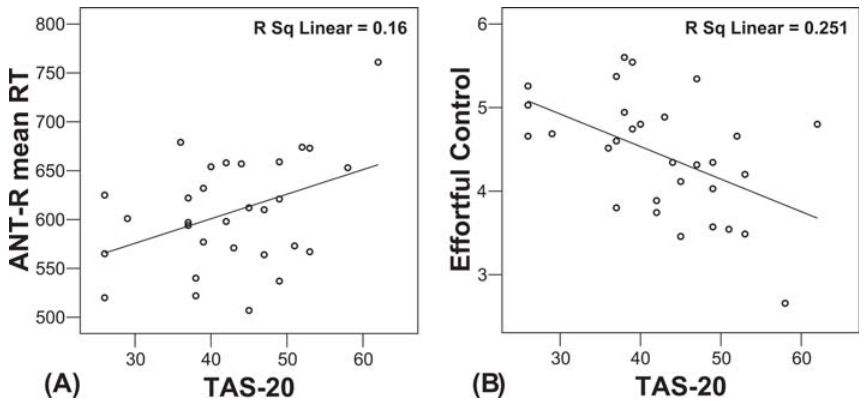
Figure 3. Correlations between overall TAS-20 score and (A) response speed of ANT-R, and (B) the Effortful Control subscale of ATQ.